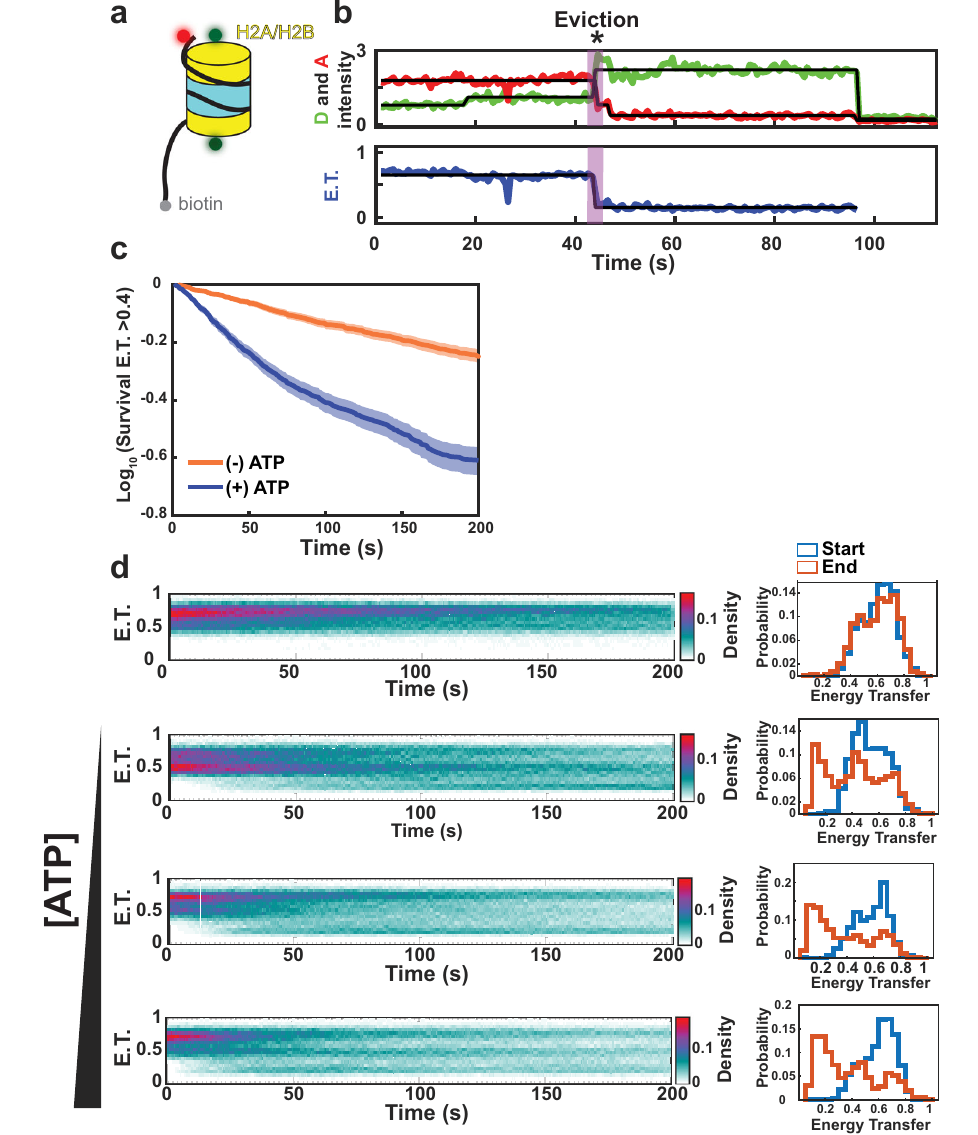
Fig. 1 | SWR1C eviction of H2A from the nucleosome is ATP-dependent. a Schematic of nucleosome substrate for smFRET studies. Mononucleosomes contained 4 and 117bp DNA linkers, with an ATTO 647N fl uorophore positioned on the end of the short linker and a biotin group on the long linker. Histone H2A was labeled at the C-terminal domain with a Cy3B fl uorophore. b Example tra- jectory. The Cy3B donor fl uorophore was excited, and donor emission (green) and ATTO 647N acceptor emission (red) were recorded (top panel) and used to calculate energy transfer ef fi ciency (blue, bottom panel). The eviction of H2A is markedby an*. c Energy transfer(>0.4)survivalkinetics(Kaplan − Meierestimate) for 0 μ M ATP ( N =962 nucleosomes from 9 replicates) (orange) and 100 μ M ATP